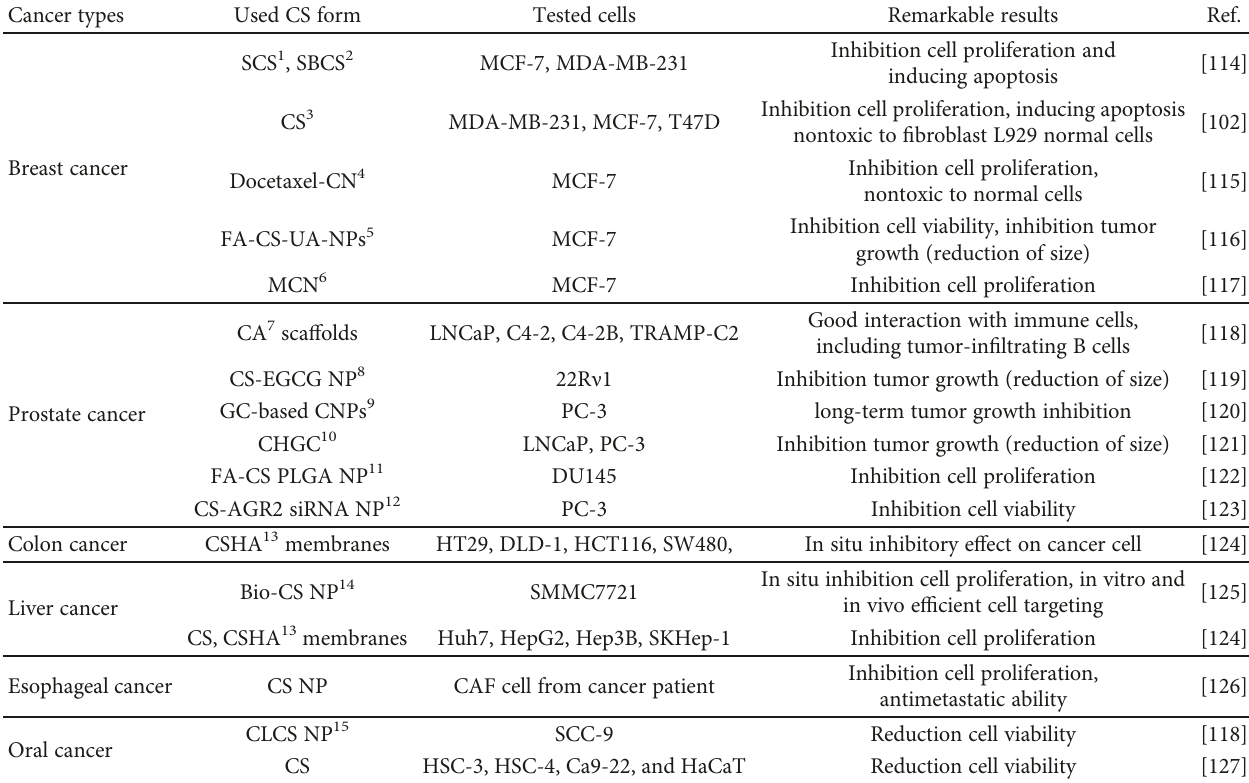
SCS 1 : sulfated chitosan; SBCS 2 : sulfated benzaldehyde chitosan; CS 3 : chitosan; docetaxel-CN 4 : docetaxel-loaded chitosan nanoparticle; FA-CS-UA-NPs 5 : folate-chitosan nanoparticles loaded with ursolic acid; MCN 6 : magnetic chitosan nanoparticles; CA 7 : chitosan-alginate; CS-EGCG NP 8 : chitosan nanoparticles encapsulating epigallocatechin-3-gallate; GC-based CNP 9 : glycol chitosan-based chitosan nanoparticles; CHGC 10 : glycol chitosan; FA-CS PLGA NP 11 : folic acid conjugated-chitosan functionalized poly (D,L-lactide-co-glycolide) nanoparticles; CS-AGR2 siRNA NP 12 : chitosan-based AGR2 siRNA nanoparticle; CSHA 13 : hyaluronan- (HA-) grafted chitosan; bio-CS NP 14 : biotinylated chitosan nanoparticles; CLCS NP 15 : curcumin-loaded chitosan-coated